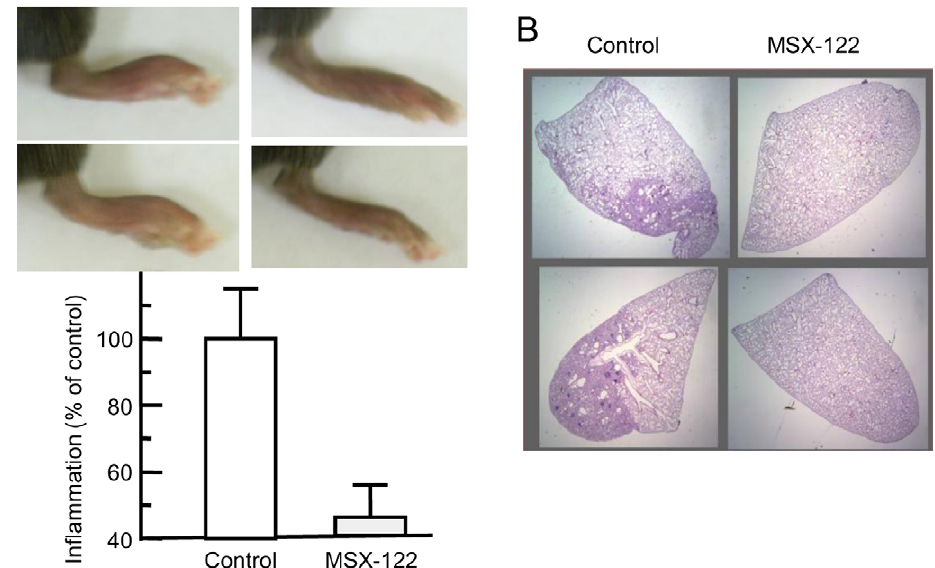
Figure 5. MSX-122 inhibits inflammation induced by carrageenan and lung fibrosis induced by bleomycin. (A) Suppression effect of anti-CXCR4 compounds on carrageenan-induced mouse paw edema. Acute paw inflammation was induced by subcutaneous injection of 50 m L of l - carrageenan in one hind paw. The mice in the treatment group were all administered CXCR4 antagonists at 10 mg/kg i.p., while control animals received corresponding i.p. injections of vehicle. Left panels show the control mice with left paw induced inflammation by carrageenan; right panels show the treated mice with left paw induced inflammation by carrageenan with about 55% suppression. (B) MSX-122 inhibits bleomycin-induced pulmonary fibrosis. A total of 20 mice, 10 in each group, received 10 mg/kg, i.p. of MSX-122ms or saline one day before bleomycin treatment and daily for 20 days. Representative H&E stainings of saline treated control (left) or MSX-122ms treated (right) lung tissues on day 20 after bleomycin treatment.